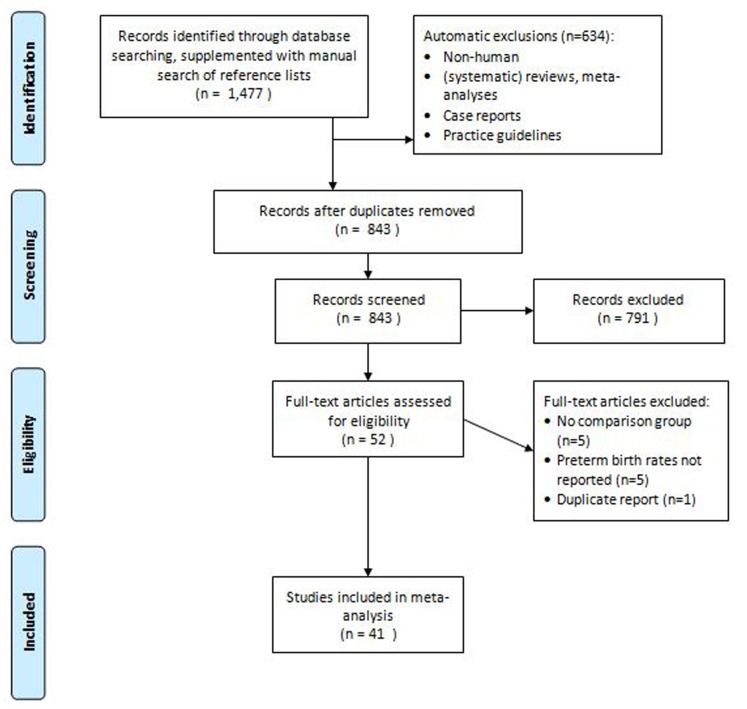
Study selection flowchart.